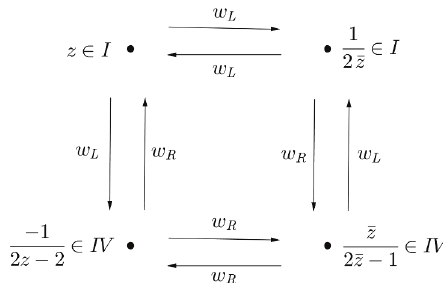
Figure 8. Closed graph describing the orbit of point z ∈ I .